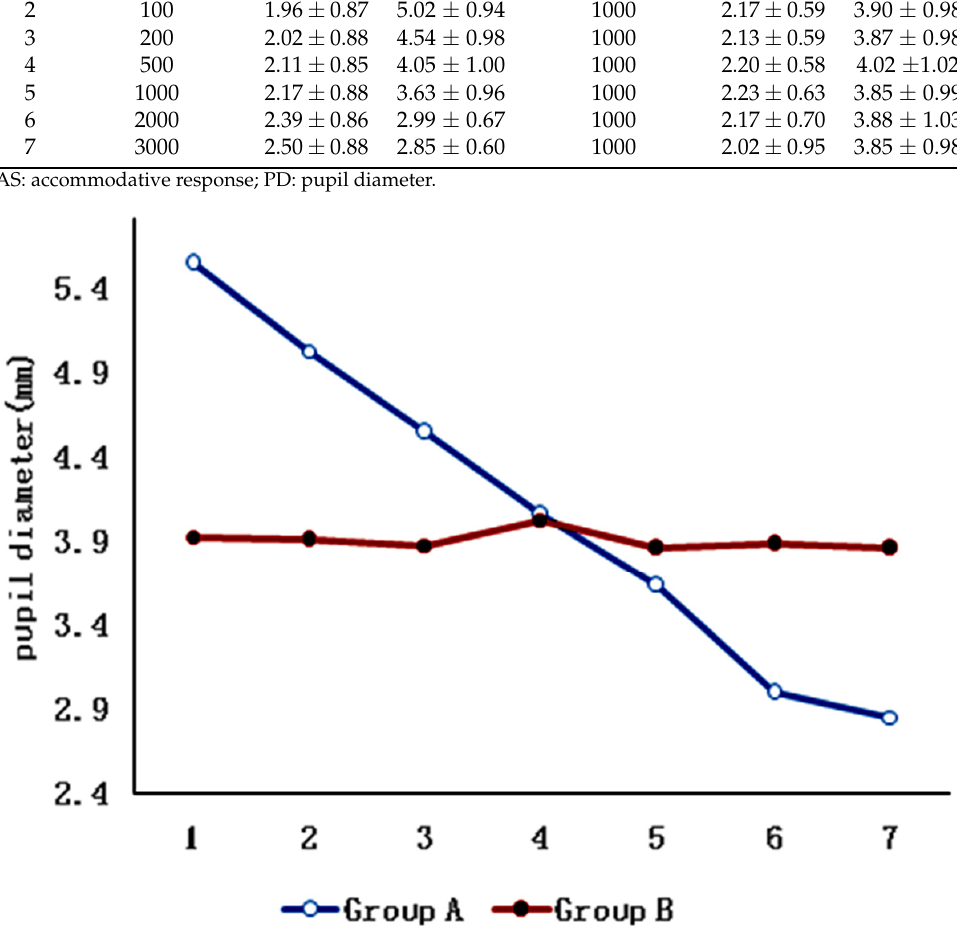
Figure 2. Effects of dynamic lighting (Group A) and static lighting (Group B) on pupil diameter. The abscissa from 1 to 7 comprises 5, 100, 200, 500, 1000, 2000 and 3000 lux illuminances for Group A. The abscissa from 1 to 7 comprises 7 sessions of 1000 lux illuminances for Group B.